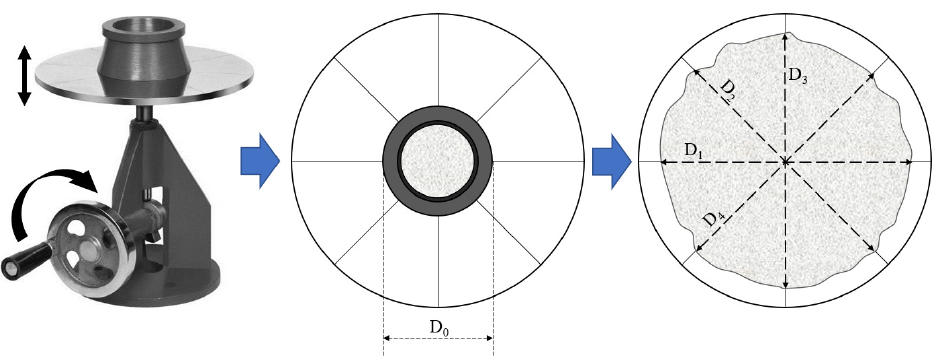
Figure 3. Schematic representation of the flowability